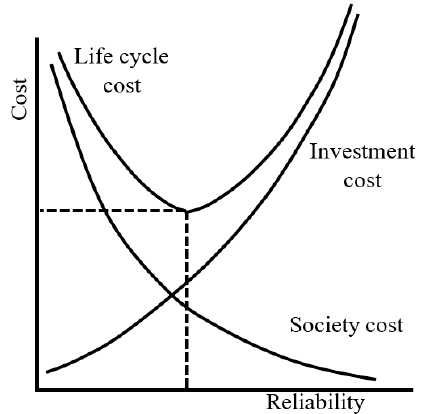
Figure 1. Correlation between reliability level and total system cost.